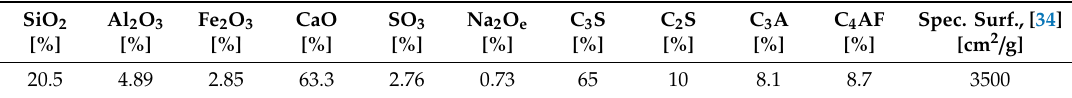
Table 5. Properties of cement CEM I 42.5. Data obtained from the cement producer.